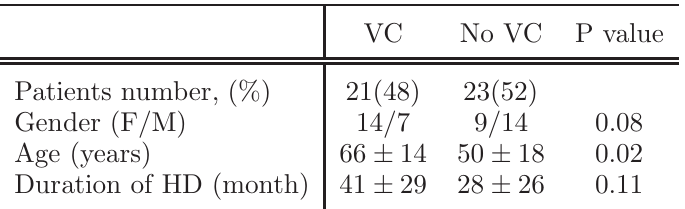
Table 1 Demographic data for the groups of HD patients with and without cardiac valve calcification (VC).